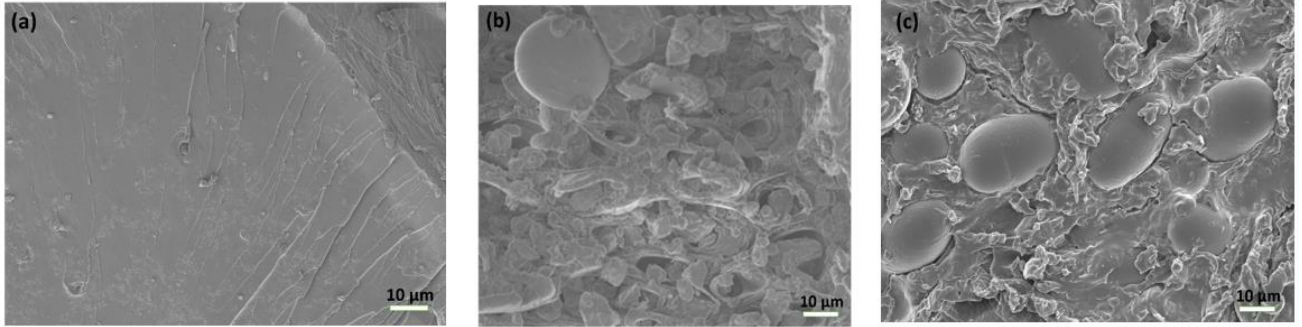
Figure 2. Scanning electron micrographs of ( a ) unsaturated polyester resin (UPT) ( b ) a representative mono reinforced composite ( c ) representative of hybrid composite.